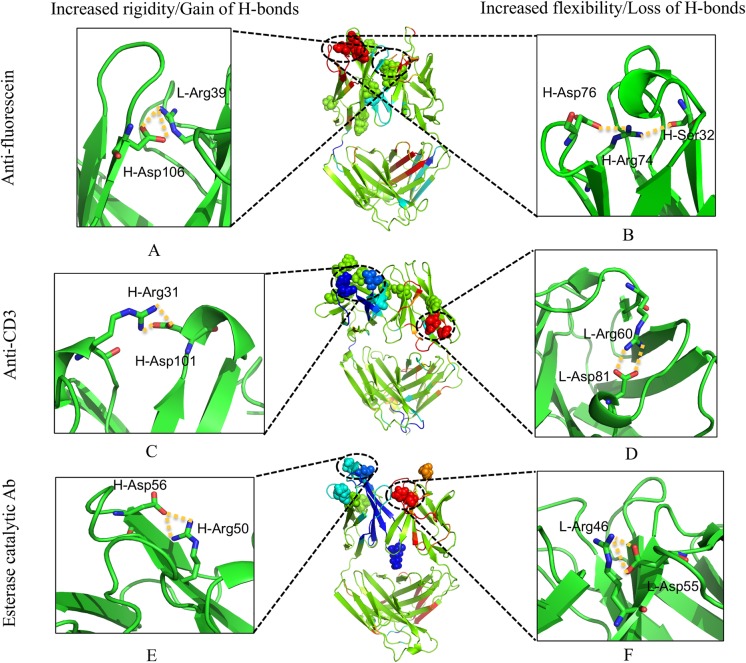
Relating flexibility differences to changes in the H-bond network.(A) and (B) are differences of hydrogen bonds for anti-fluorescein antibody, respectively. (C) and (D) for anti-CD3 antibody. (E) and (F) for esterase catalytic antibody. Regions that exhibit significant increased rigidity/flexibility are affected by gain/loss local H-bonds. Large increases in rigidity due to gain of H-bonds are displayed in the left panel while large increases in flexibility due to loss of H-bonds are in the right panel. The middle panel shows the same as in Fig 5. Hydrogen bonds are highlighted in yellow dashed lines.